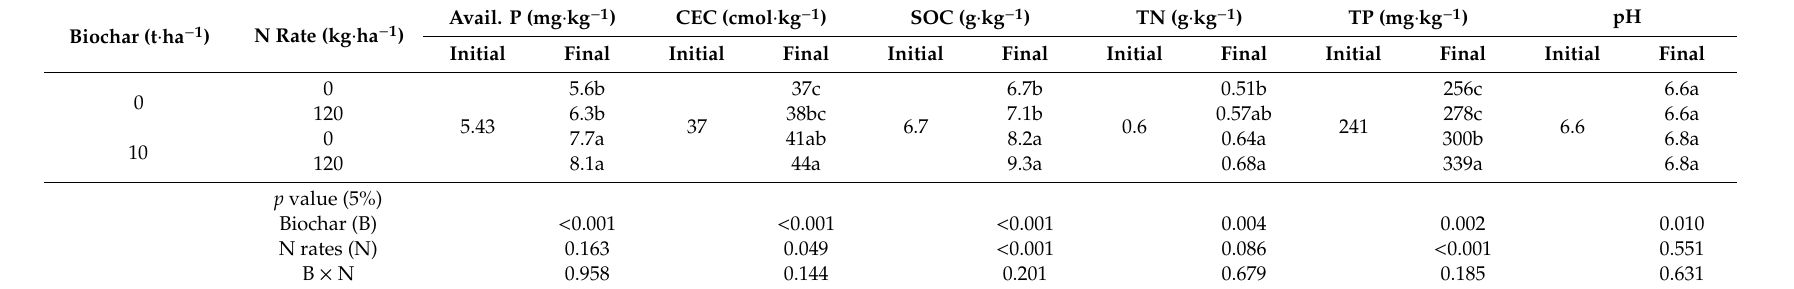
Table 8. E ff ect of rice husk biochar and inorganic fertilizer on soil (0–15 cm) chemical